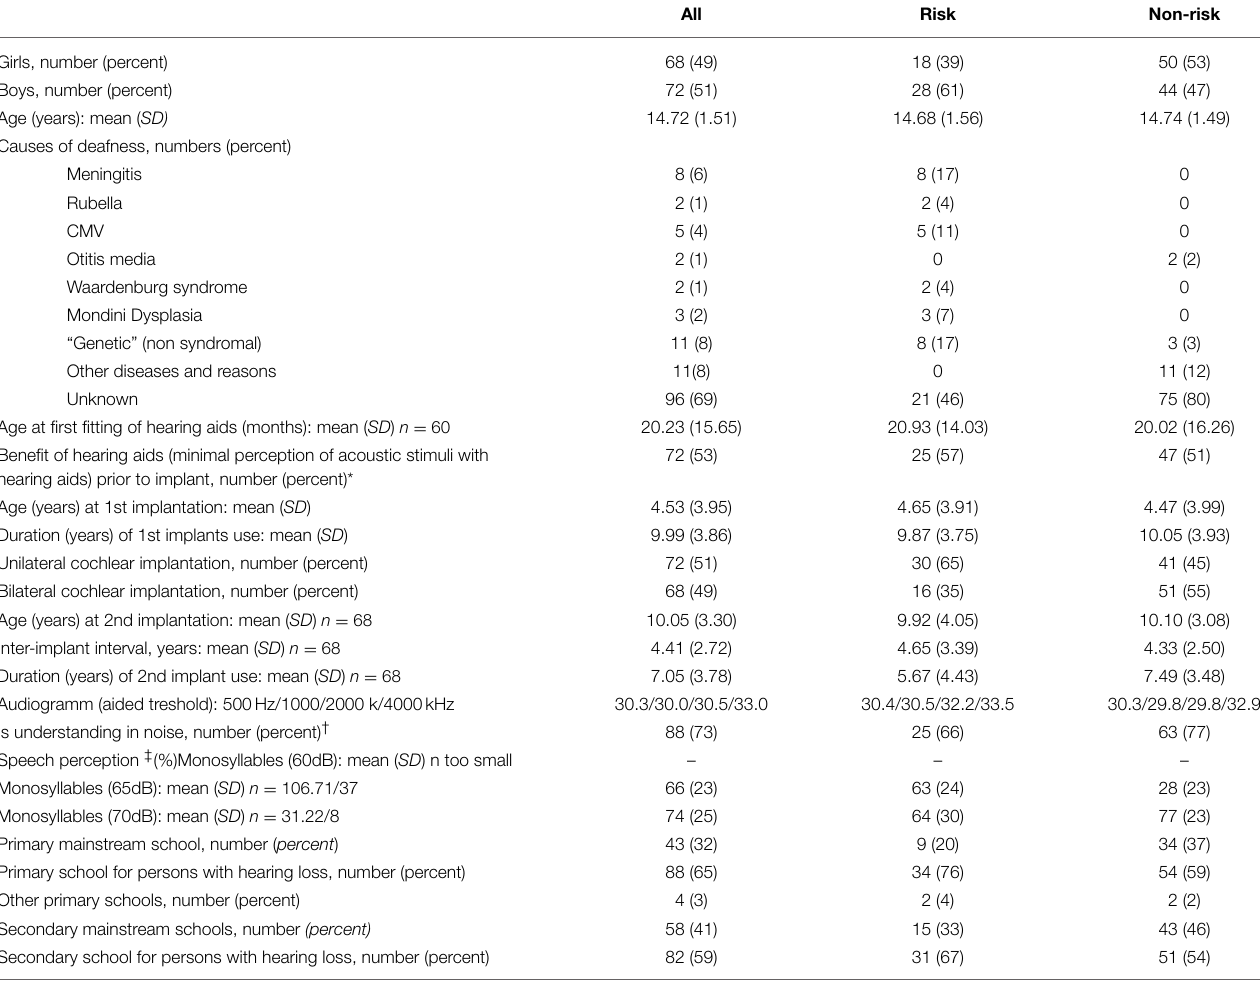
TABLE 2 | Demographic data of 140 adolescents with cochlear implants participating in the study including (“non-risk group”) 46 CI users with indication for additional handicaps and non-classifiable persons (“risk group”) and 94 CI users without additional handicaps (“non-risk group”). All Risk